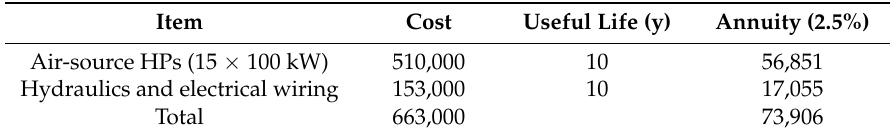
Table A6. CAPEX of the reference system.